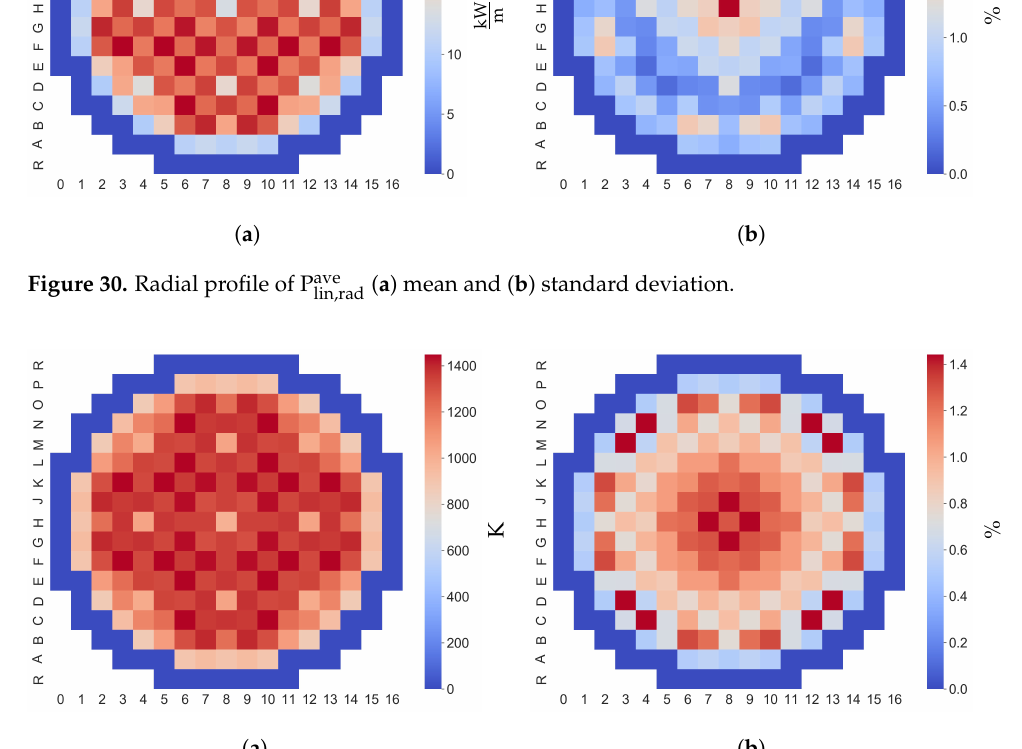
( a ) mean and ( b ) standard fc,rad